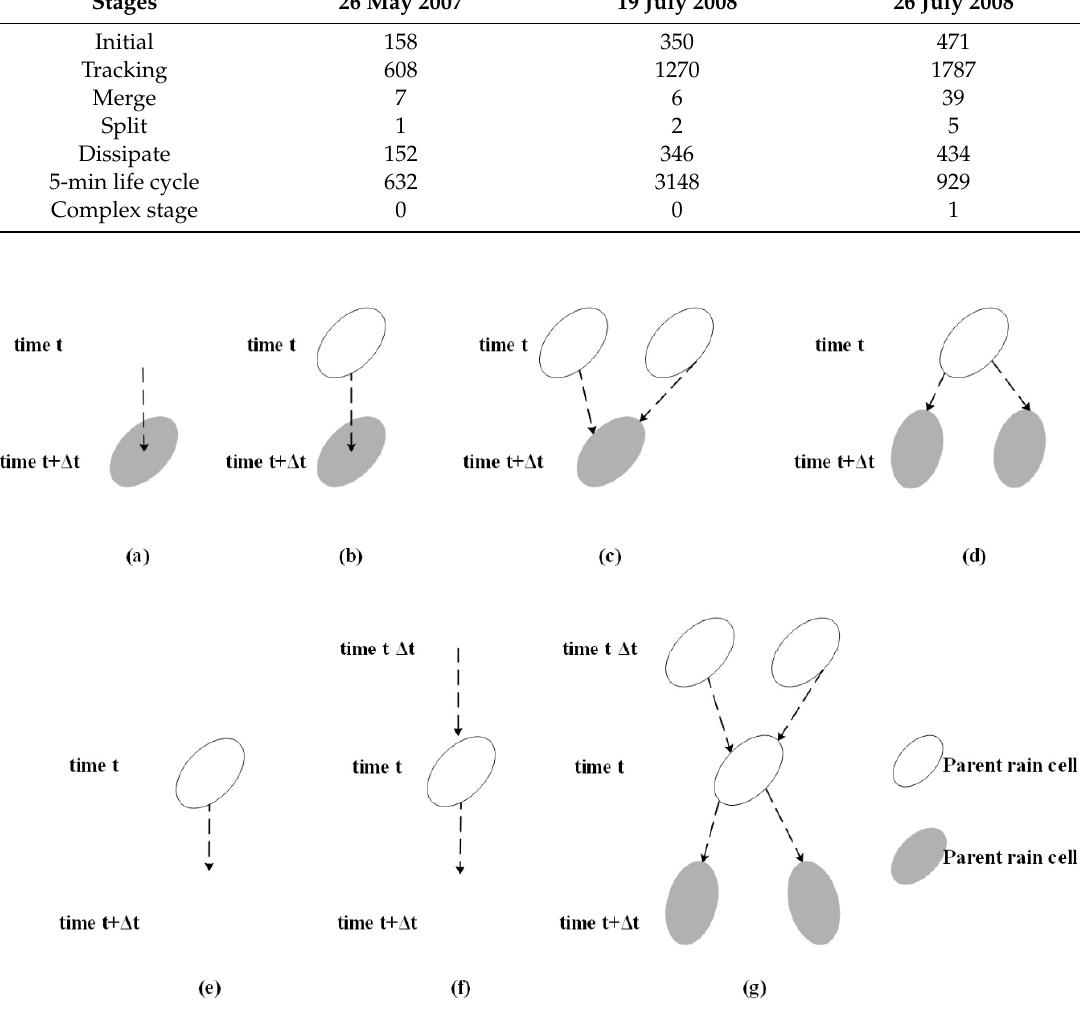
Figure 8. Five rain cell life stages of rain cells: ( a ) Initial, ( b ) Tracking, ( c ) Merging, ( d ) Splitting, ( e ) Dissipating, ( f ) 5-min life cycle, ( g ) Complex stage. Table 3. Number of rain cells with different life stages, sorted by selected rain